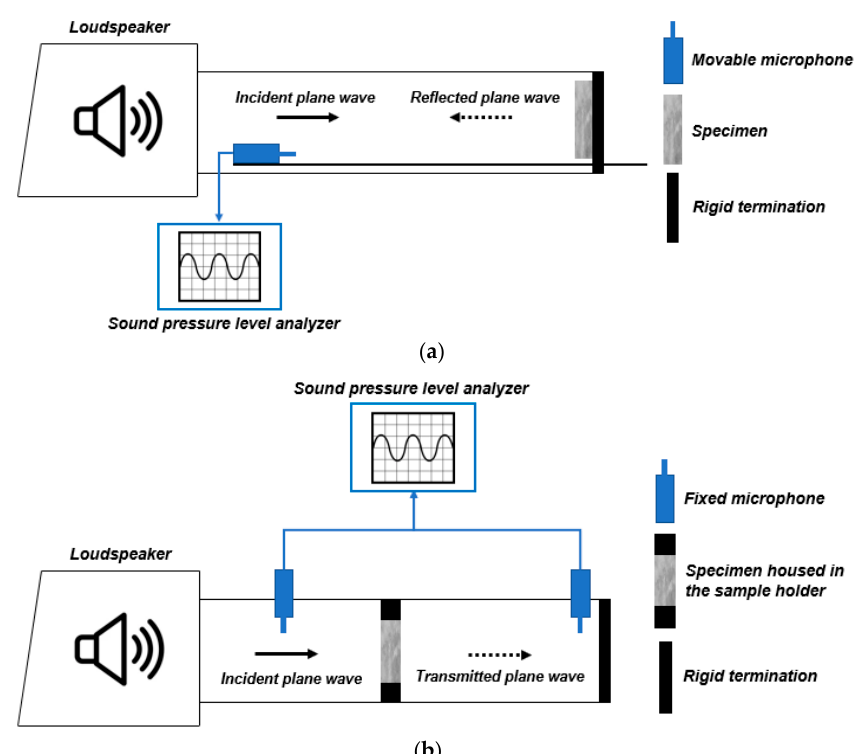
Figure 8. Schemes of the impedance tube configuration for ( a ) acoustic absorption measurements and ( b ) acoustic flow resistivity tests.